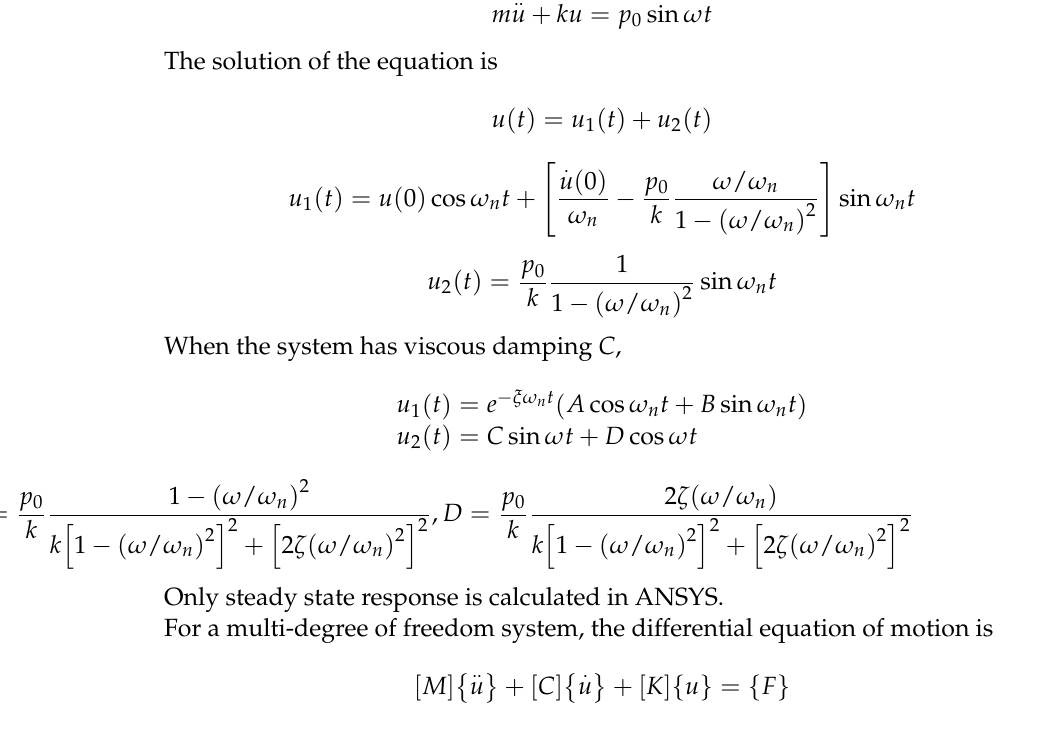
Figure 5. Grid independence analysis.